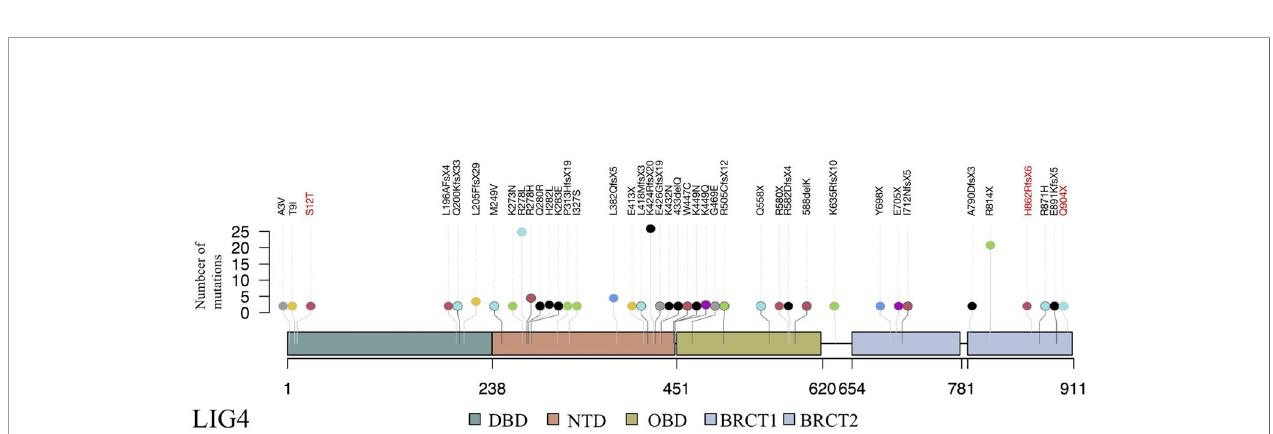
FIGURE 4 | Schematic presentation of the LIG4 gene structure and a summary of mutation sites. The novel mutation sites identi fi ed in this study are shown in red. The height of the line represents the number of mutations. DBD, DNA-binding domain; NTD, nucleotidyltransferase domain; OBD, oligo-binding domain; XBD, XRCC4-binding